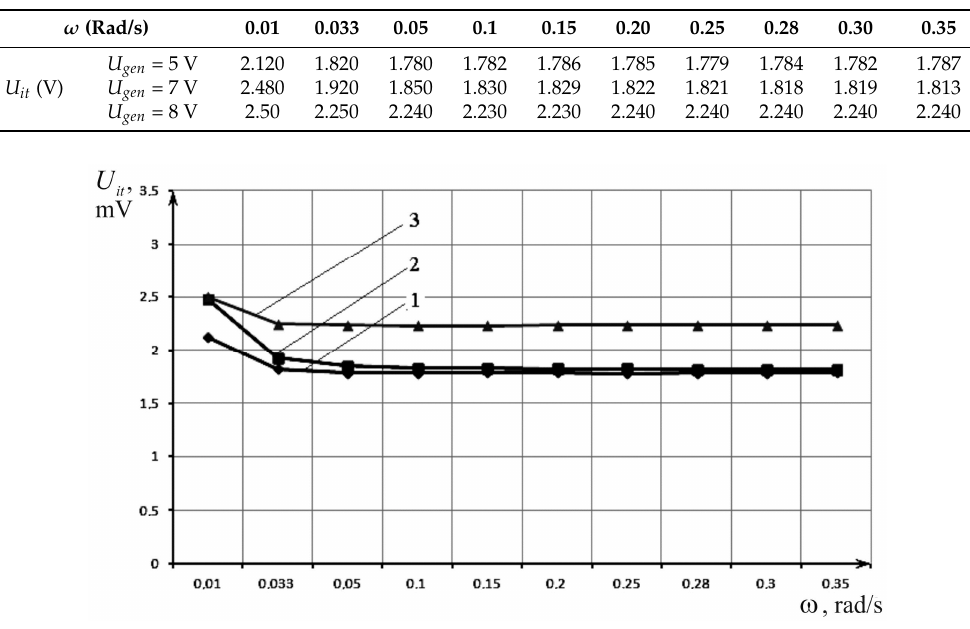
Figure 8. Dependence of the IP output voltage on the vibration table oscillation frequency at different excitation voltages: 1— U it = ψ ( ω ) at U gen = 5 V; 2— U it = ψ ( ω ) at U gen = 7 V; and 3— U it = ψ ( ω ) at U gen = 8